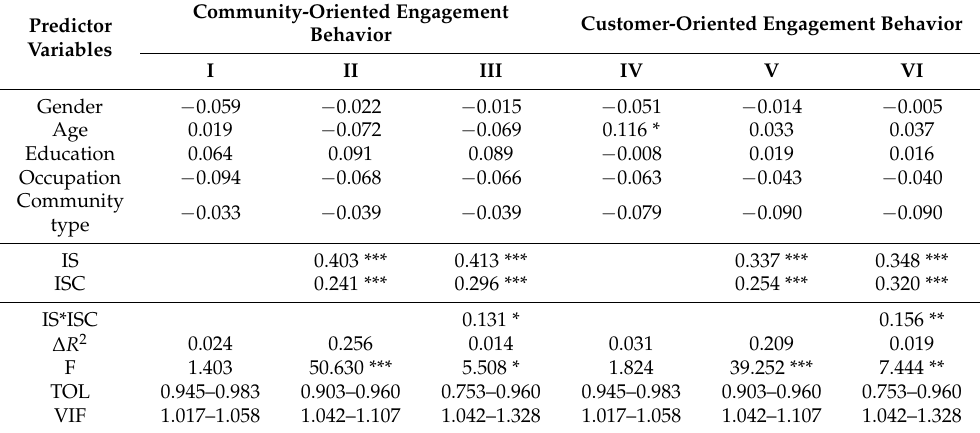
Table 5. The result of the moderation of interdependent self-construal in the relationship between informational support and the two dimensions of